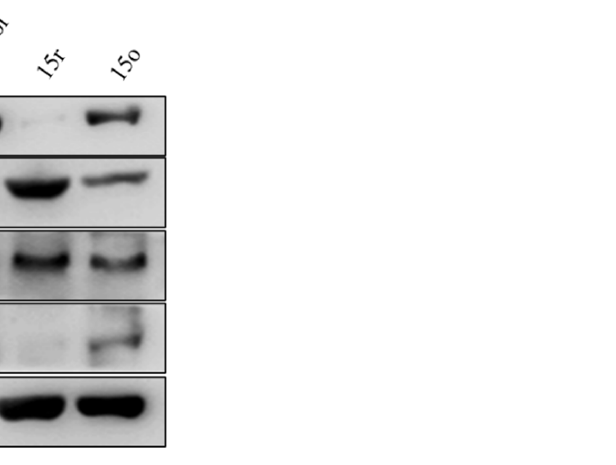
Figure 9. Effects of 15o (1 μ M) and 15r (2 μ M) on major proteins related to cell proliferation. Western blot analysis detected the expression levels of PI3K p85, β -actin, AXIN-2, TAB-182, and β -catenin proteins.